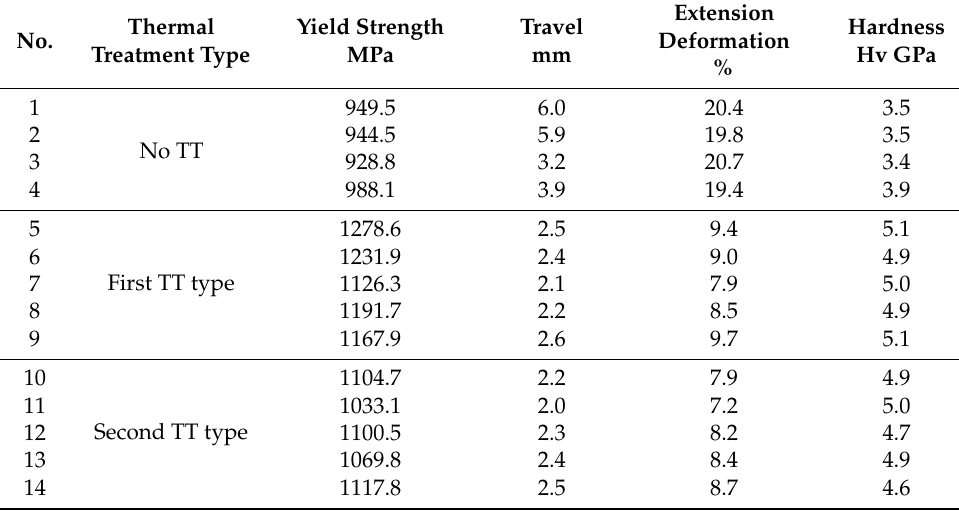
Table 2. The mechanical testing results of the fabricated